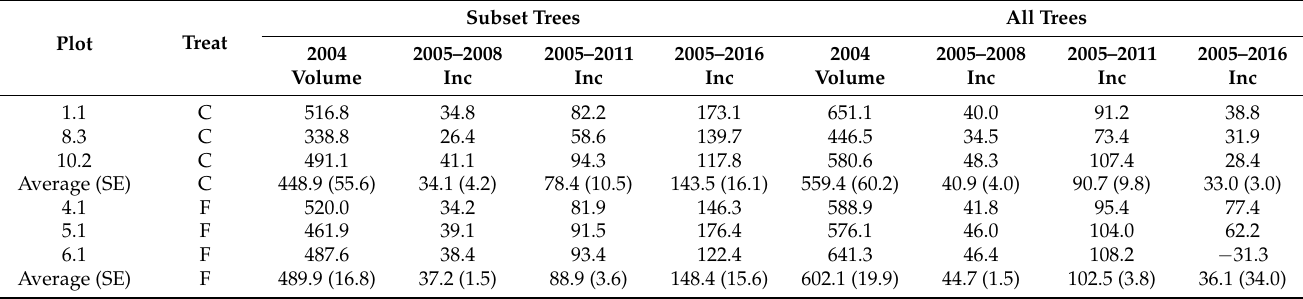
Table 2. Plot level stem volumes (m 3 ha − 1 ), cumulative volume increments, and control (C) or fertilized (F) treatment averages for the subset trees in the plots, as well as all trees.